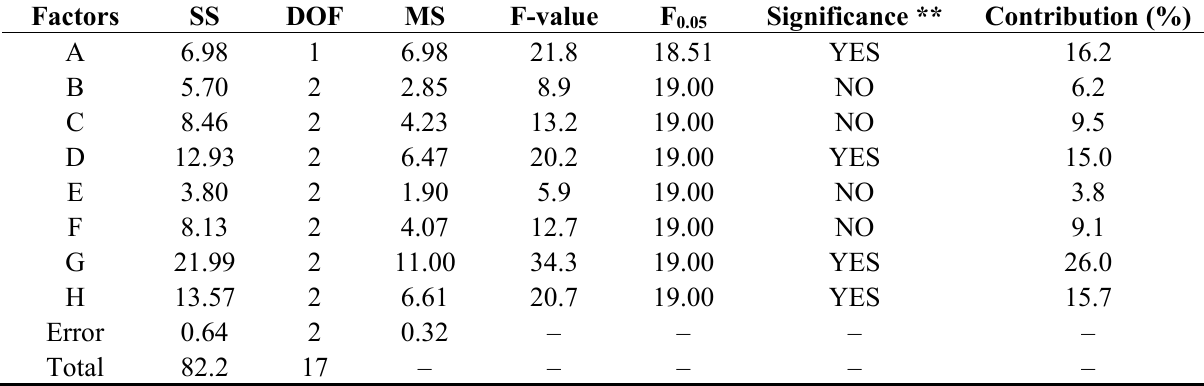
Table 4. Result of ANOVA for 2D roundness